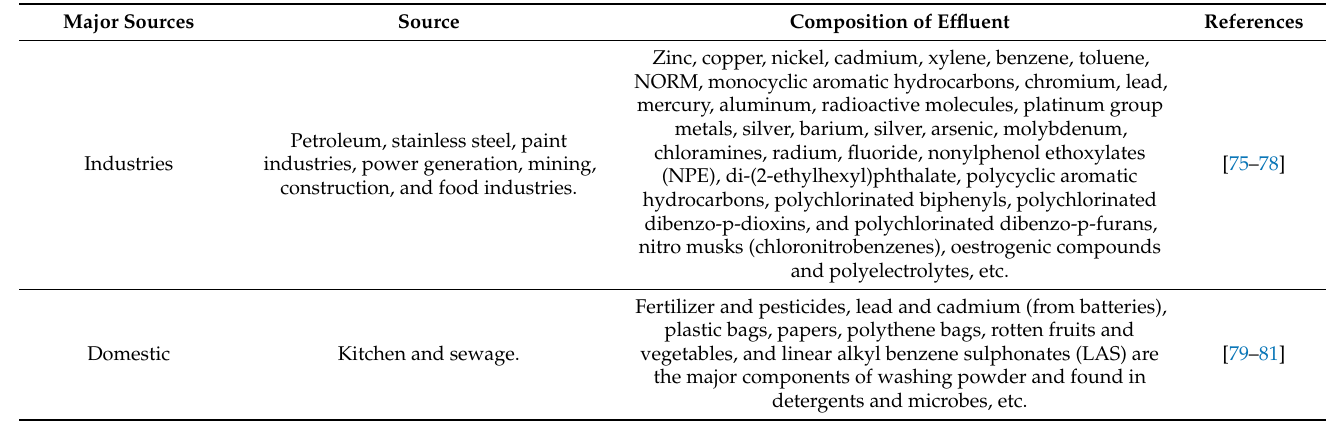
Table 2. Industrial and domestic and their effluent composition